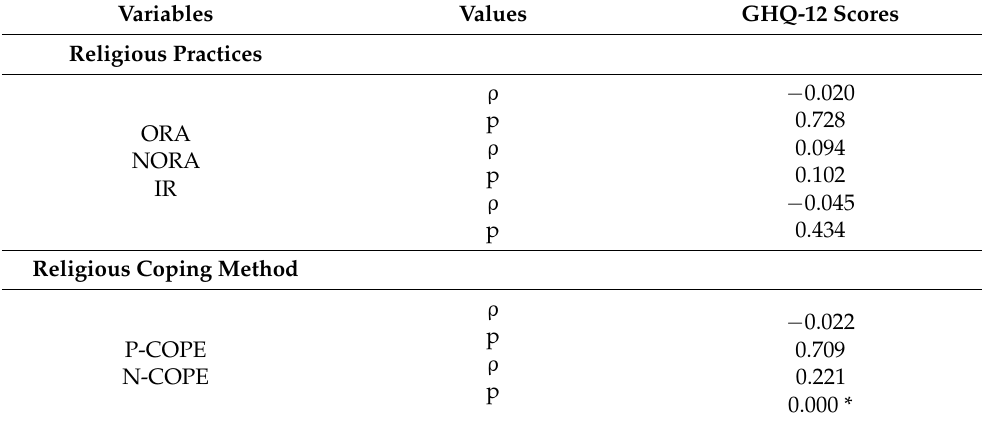
Table 3. Correlations among religious practice, religious coping methods, and psychological